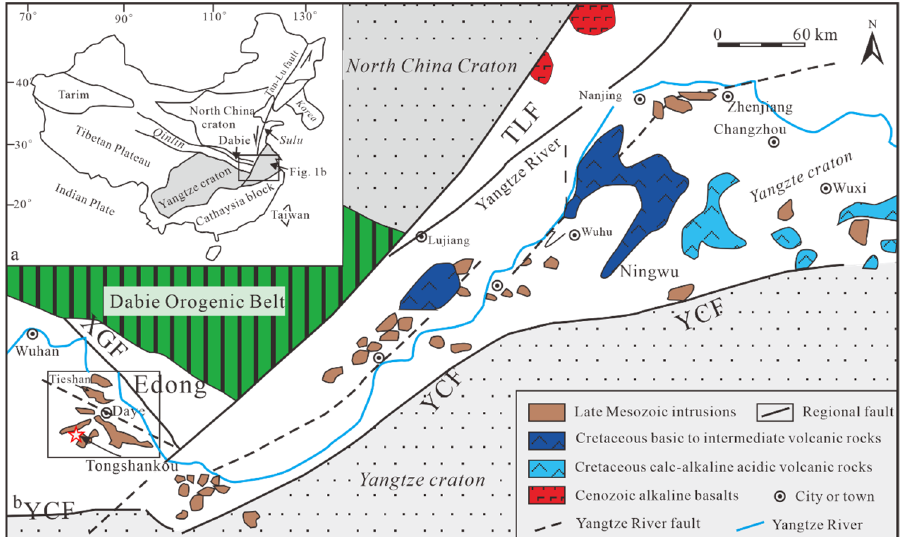
Figure 1. ( a ) Simplified geologic map of the Middle–Lower Yangtze River belt (MLYRB), modified after [9–13]. Abbreviations: TLF–Tancheng–Lujiang Fault, XGF–Xiangfan–Guangji Fault, YCF– Changzhou–Yangxin Fault; ( b ) detail location of the Edong ore district and simple illustration of surrounding geology environment (modified after